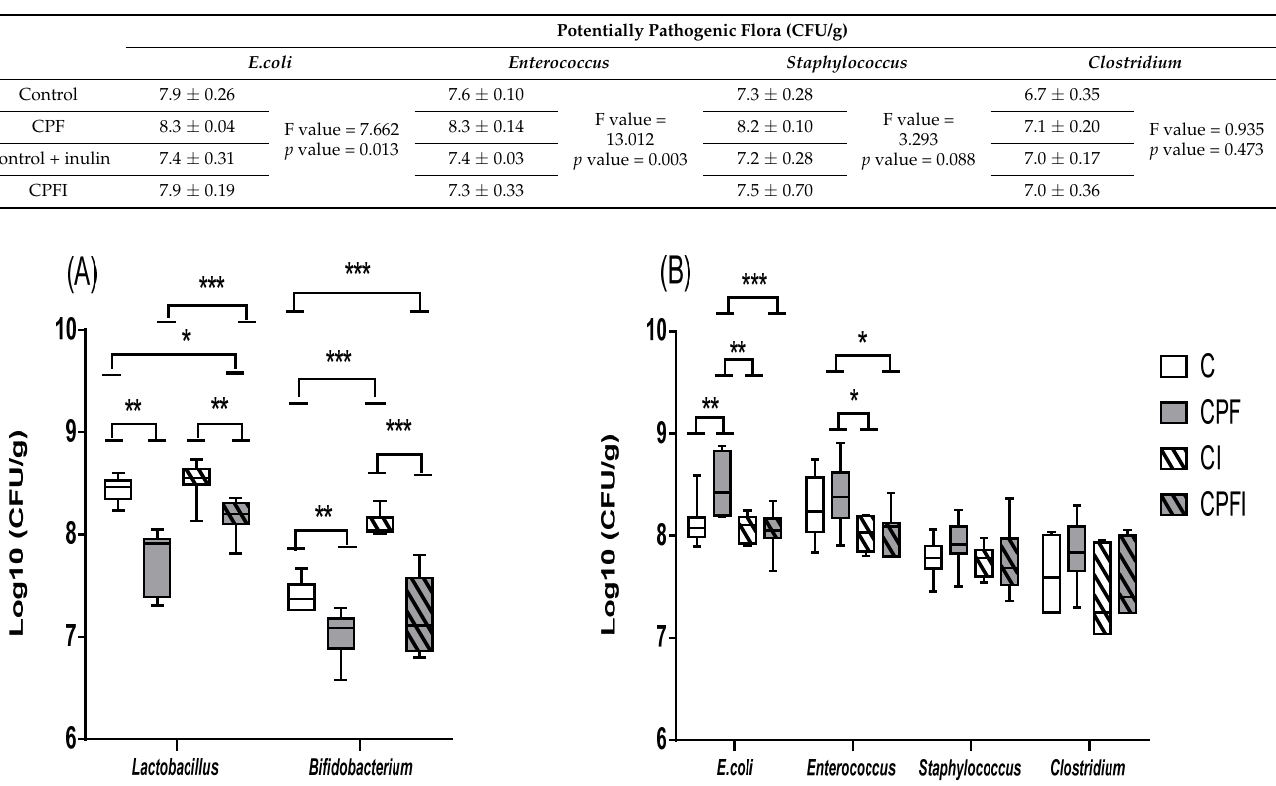
Table 4. Effects of exposure to CPF and inulin on potentially pathogenic flora in dams. The values are expressed as mean ± SEM ( n = 4). Significantly different ( p < 0.05) using analysis of variance (ANOVA) and Tukey’s test. C: Control; CPF: Chlorpyrifos; CI: Control inulin; CPFI: Chlorpyrifos + inulin.